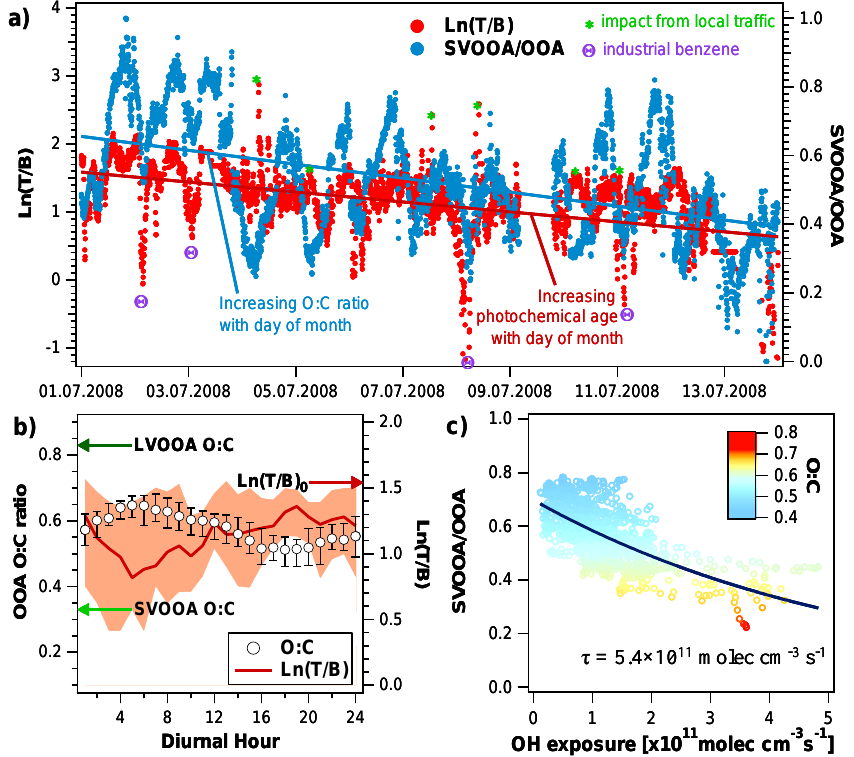
Fig. 8. OOA photochemical aging. (a) presents the correlation between Ln (T/B) and SVOOA/OOA, indicating the photochemical transformation of SVOOA into LVOOA in aged air masses with low Ln (T/B) . Episodes of local pollution affecting the toluene/benzene ratios are indicated by green stars for traffic related episodes (high toluene/benzene ratios) and by purple hexagons for industrial emissions of benzene. The brown and blue lines represent the fits vs. time of Ln (T/B) and SVOOA/OOA, respectively, indicating an increase of air masses photochemical age with day of month. (b) represents the diurnal patterns for Ln (T/B) and OOA O : C (which is inversely proportional to the SVOOA/OOA ratio). It shows that the photochemical age of air masses increases during nighttime, leading to higher O : C ratios. Using toluene/benzene ratios, we estimated the OH exposure inmoleculescm − 3 s − 1 (Eq. 3). In (c) , SVOOA/OOA is plotted against the OH exposure for periods when OOA dominated (HOA < 5% and F4 < 1%). An exponential time constant ( τ) of 5.4 × 10 11 moleculescm − 3 s − 1 is estimated by fitting the data with an exponential decay